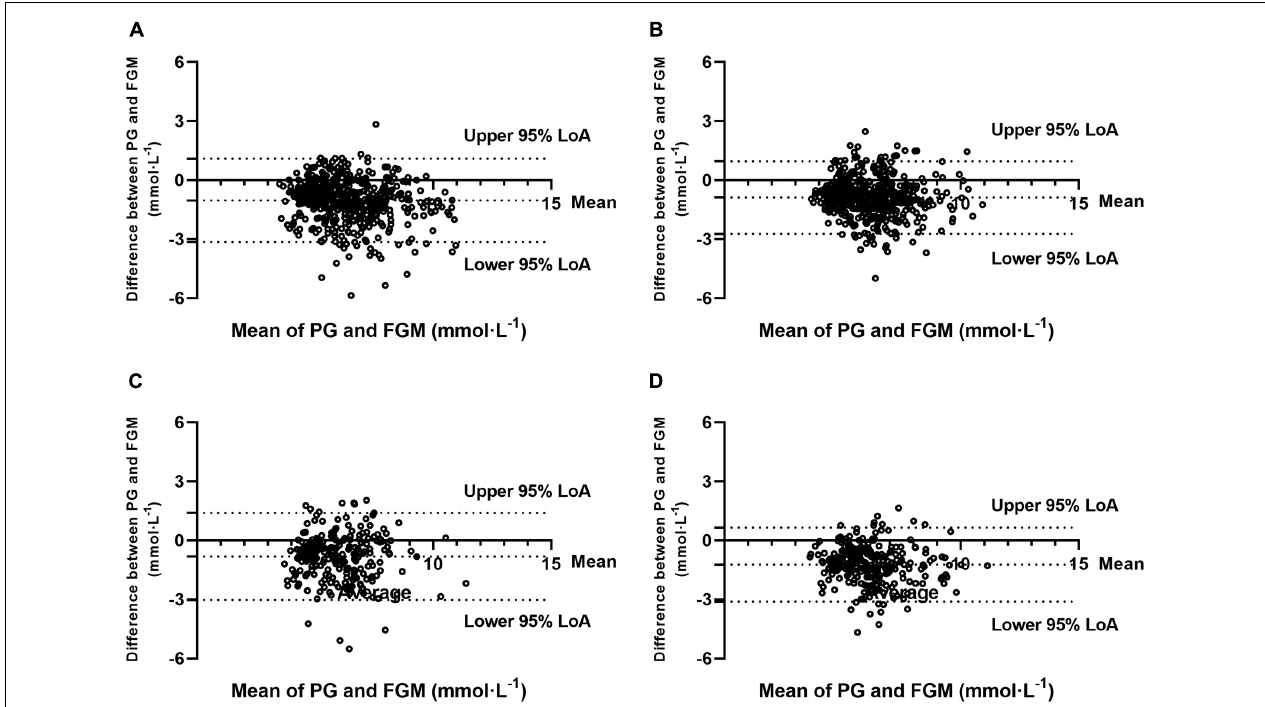
FIGURE 3 | Bland-Altman plots for the comparison of PG and FGM values during (A) SIT, (B) 20iP + CONT, (C) iP + CONT, and (D) 20iP + ACCU. 95% LoA, 95% Limit of Agreement; PG, plasma glucose; FGM, interstitial glucose monitored by FGM; SIT, sitting. 20iP + CONT: walking continuously for 30 min initiated 20 min before each participant’s postprandial glucose peak (PPGP); iP + CONT: walking continuously for 30 min initiated at PPGP; and 20iP + ACCU: walking accumulated for 30 min initiated 20 min before PPGP (three bouts of 10 min walking separated by 20 min of